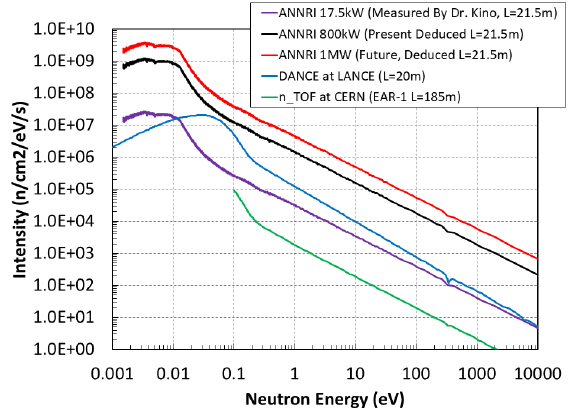
Figure 2. Neutron intensities per second at the 21.5-m sample position of ANNRI under 17.5-kW operation compared to that of DANCE at LANSCE and n TOF at CERN [10]. The deduced present neutron intensity under 800-kW operation and the ex- pected neutron intensity under the future 1-MW operation are also